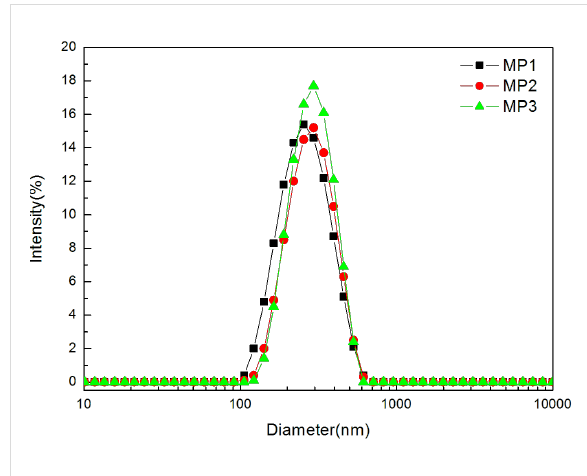
Figure 1: Particle size distributions of MP1, MP2, and MP3 at 25 °C as determined by DLS.